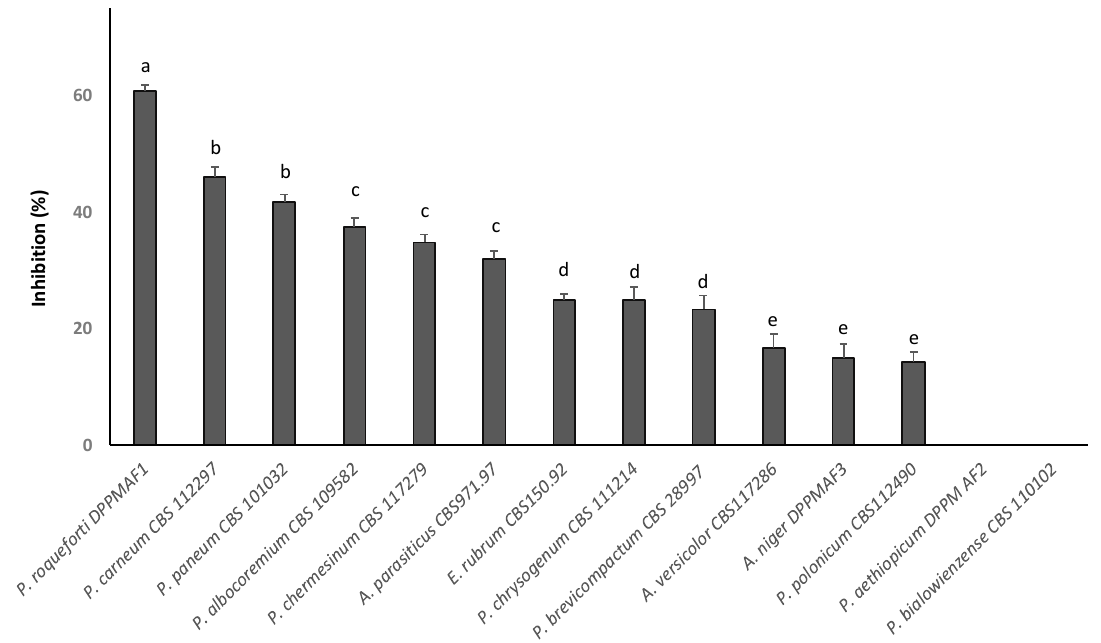
Figure 1. Inhibitory spectrum of the water/salt-soluble extract from chickpea sourdough (30%, v/v , on Potato Dextrose Agar (PDA) medium), as determined by the hyphal radial growth rate of fungi, after 6 days of incubation at 25 °C. a – e Values with different superscript letters differ significantly ( p < 0.05). Each datum point is the mean of at least four measurements of a growing colony. The percentage of growth inhibition was calculated from mean values as follows: % inhibition = [(mycelial growth under control conditions − mycelial growth in the presence of water/salt-soluble extract)/mycelial growth under control conditions] × 100.